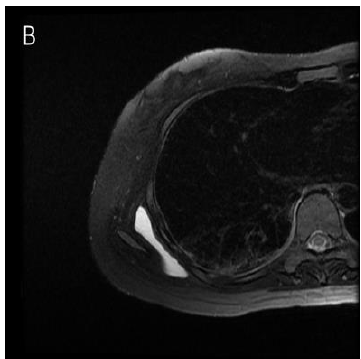
Figure 2. Right shoulder enhanced magnetic resonance imaging showing soft tissue fluid collection (6.0 cm × 6.0 cm × 2.0 cm) in the right posterolateral chest wall, which was suspected to be scapulothoracic bursitis. ( A ) T1-weighted axial spin echo view. ( B ) T2-weighted axial fast spin echo view.